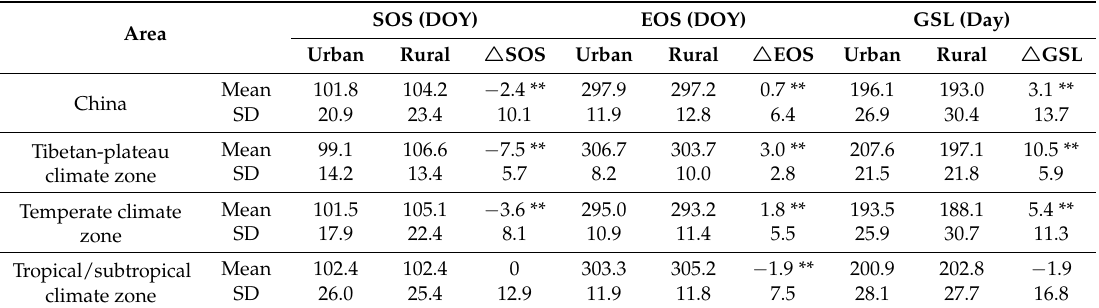
Table 1. The impact of urbanization on vegetation phenology.